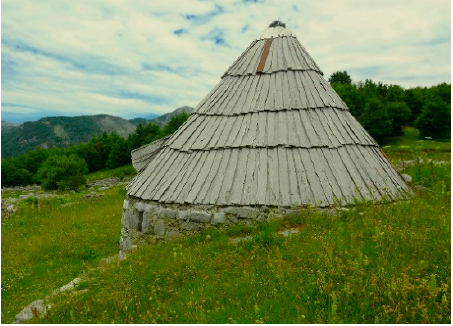
Figure 10. Dubirog at Korita, photo: I. Lakovi ć .